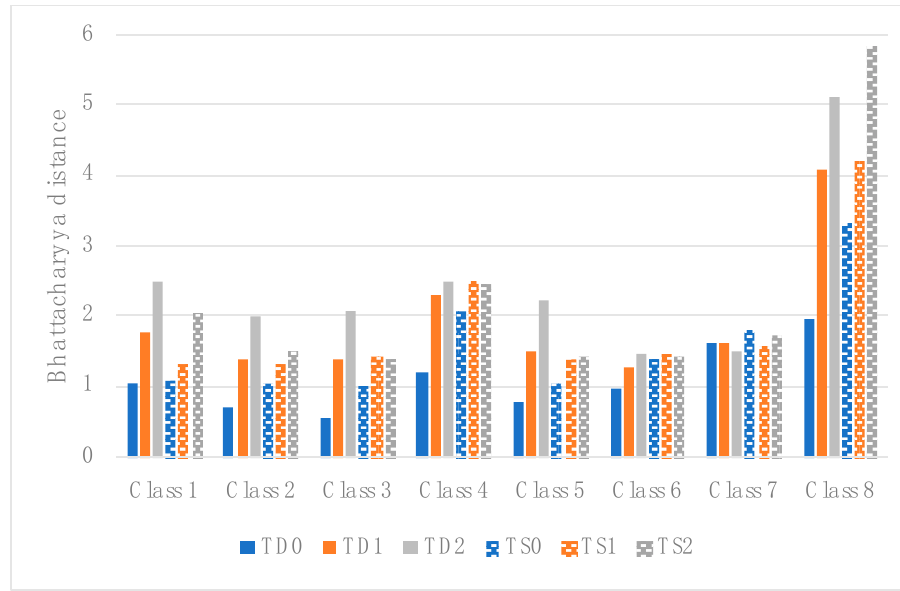
Figure 9. Class separability per class for the TD0, TD1 and TD2 datasets and the samples TS0, TS1 and TS2 extracted from these datasets to train the classifier for study area A.